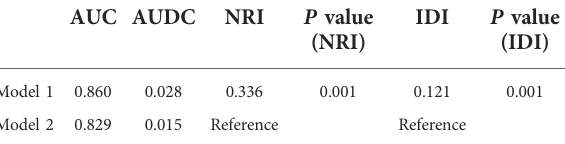
TABLE 3 Model performance